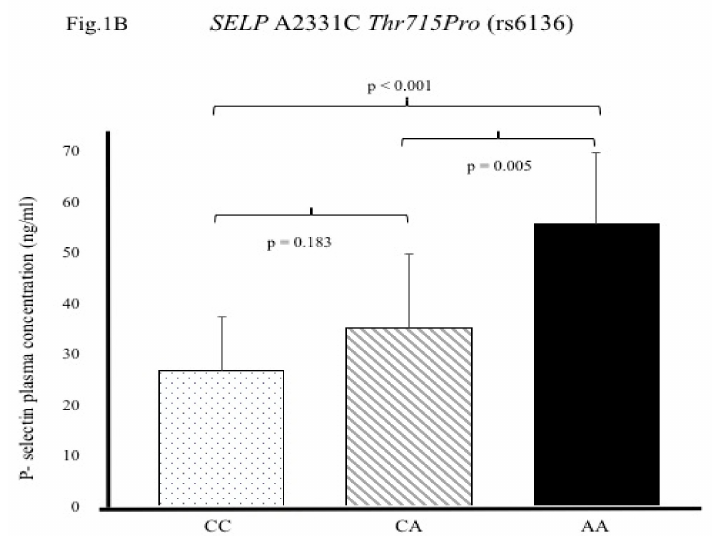
Figure 1. Genetic contribution of the SELP G1057A and SELP A2331C polymorphisms on P-selectin levels. ( A ) P-selectin plasma levels in individuals with di ff erent genotypes of the SELP G1057A polymorphism. ( B ) P-selectin plasma levels in individuals with di ff erent genotypes of the SELP A2331C